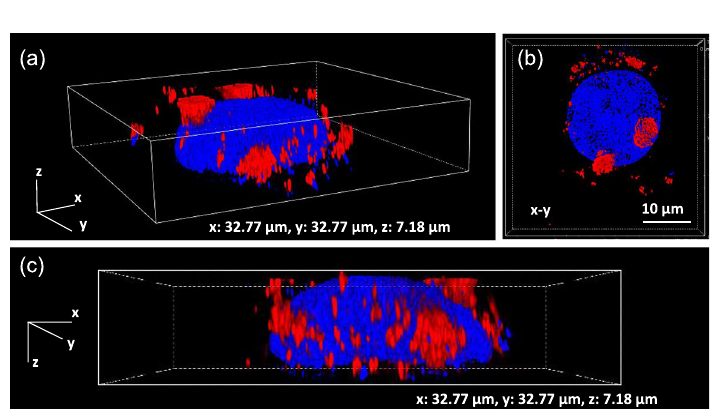
Figure 5. Super-resolution fluorescence image of ND-labeled HeLa cells fixed on coverslip. ( a ) Three- dimensional fluorescence images of the nucleus (blue) and NDs (red). ( b , c ) Corresponding two-dimensional images of xy and xz